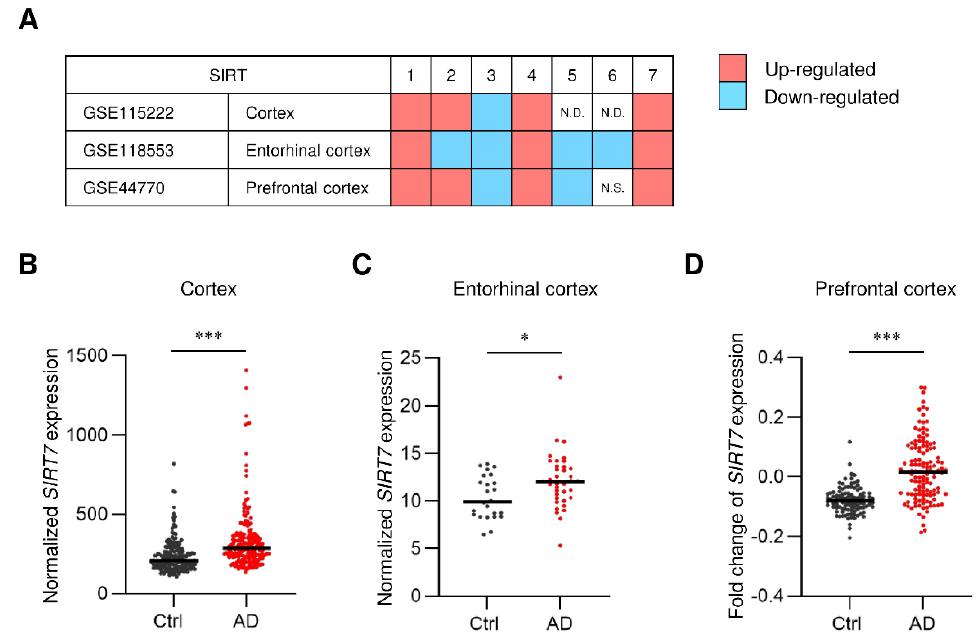
Figure 1. SIRT7 expression is increased in the brain of AD patients. ( A ) Meta-analysis comparing three public microarray datasets of patients with AD (GSE15222, GSE118553, and GSE44770). The mRNA expression of SIRT1–7 was compared between AD and control patients. Red and blue boxes represent the upregulation or downregulation of the indicated gene, respectively. N.D., not detected. N.S., not significant. ( B – D ) Scatter plot of SIRT7 mRNA expression in ( B ) cortex from 176 non-AD samples and 187 AD samples (GSE15222), ( C ) entorhinal cortex from 27 non-AD samples and 52 AD samples (GSE118553), and ( D ) prefrontal cortex from 101 non-AD samples and 129 AD samples (GSE44770). Solid lines indicate the median value for each group. All data are shown as the mean ± SEM. Statistical significance was determined by Student’s t -test. * p < 0.05; *** p < 0.001.